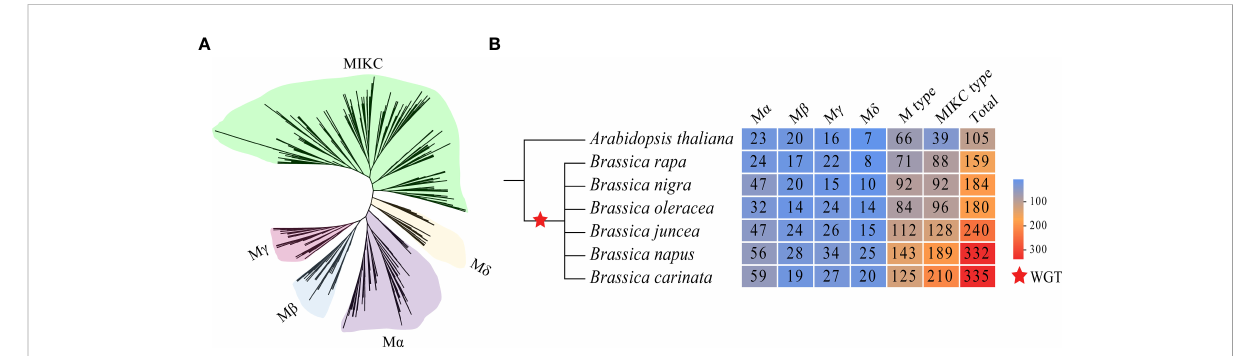
FIGURE 1 Evolutionary tree of MADS-box proteins in the six U ’ s triangle species and A thaliana and the number of subfamily members. (A) The phylogenetic tree of 1535 MADS proteins was constructed using the maximum likelihood method, and different colors represent different subfamilies. (B) The red star represents that the genome has undergone a genome-wide triplication event